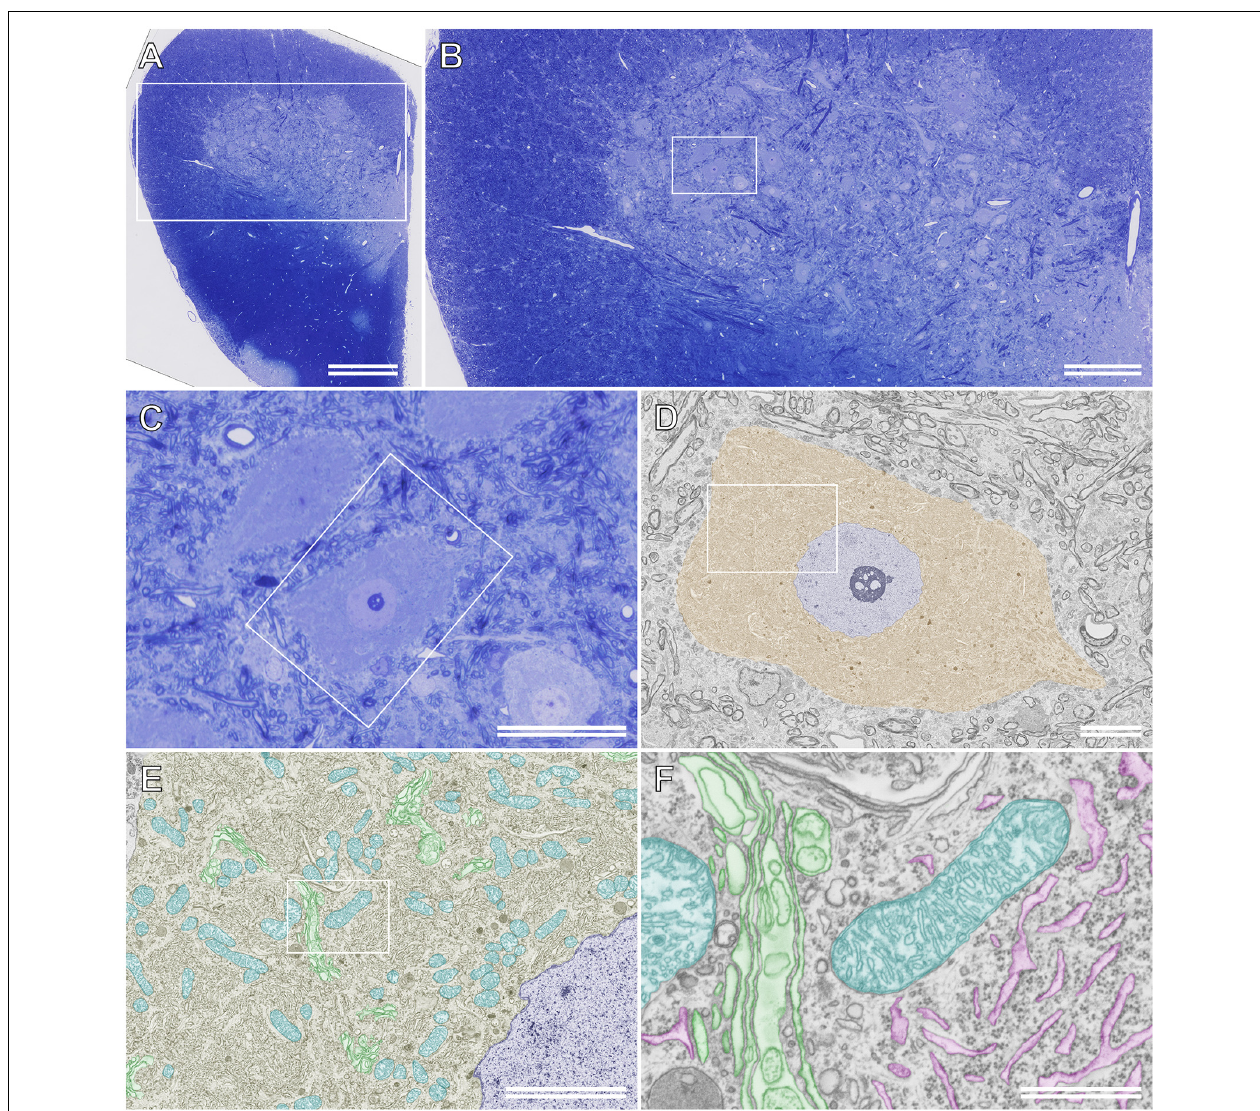
FIGURE 6 | Semithin section of the rat spinal cord observed using light microscopy (LM) and scanning electron microscopy (SEM). (A) A whole image of the resin-embedded semithin section observed using LM. The section is stained with toluidine blue. The boxed area is enlarged and shown in (B) . (B) LM images of the semithin section of the boxed area in (A) . The boxed area is enlarged and shown in (C) . (C) LM image of the semithin section of the boxed area in (B) . (D) The boxed area in (C) is observed using backscattered electron (BSE)-mode SEM. Brown: soma of the motor neuron, blue: nucleus. The boxed area is enlarged and shown in (E) . (E) Closer view of the motor neuron. Blue: nucleus, cyan: mitochondria, green: Golgi apparatus. The boxed area is enlarged and shown in (F) . (F) High-resolution image of the motor neuron. The ultrastructure of the Golgi apparatus (green), rough ER (magenta), and mitochondria (cyan) were imaged using BSE-mode SEM. (A) Scale bar: 500 µ m; (B) scale bar: 200 µ m; (C) scale bar: 50 µ m; (D) scale bar: 10 µ m; (E) scale bar: 5 µ m; (F) scale bar: 1 µ